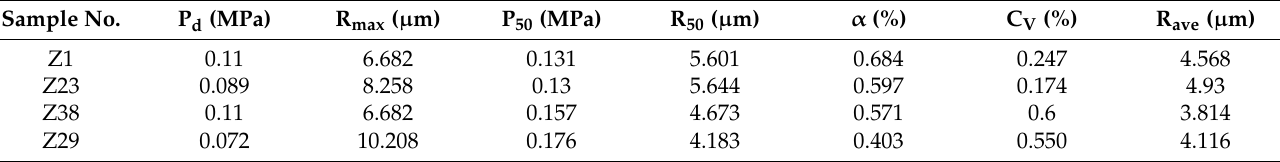
Table A2. Some character parameters of mercury injection capillary pressure (MICP)